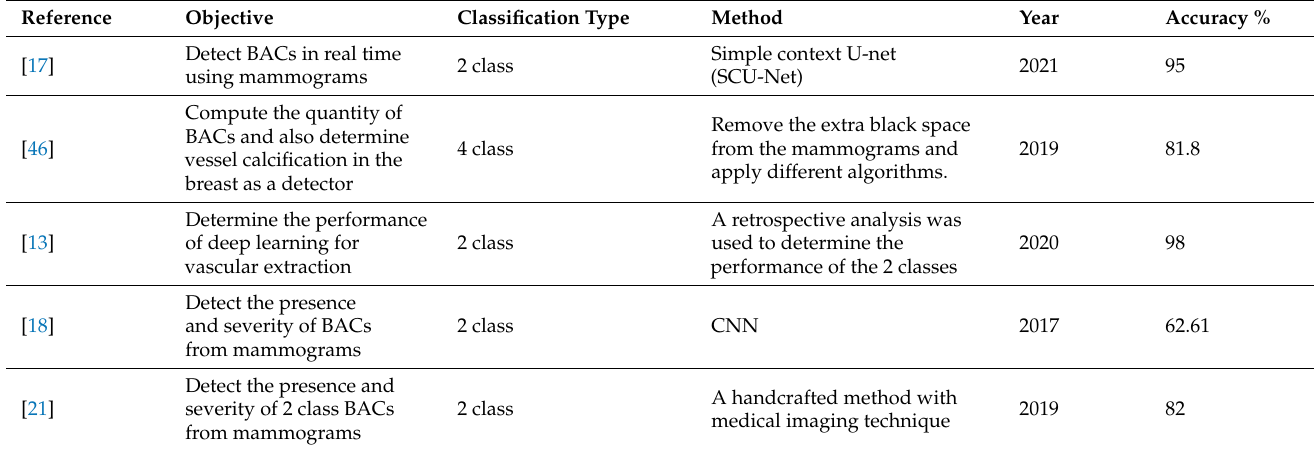
Table 5. Summary of the quantitative recent approaches in the